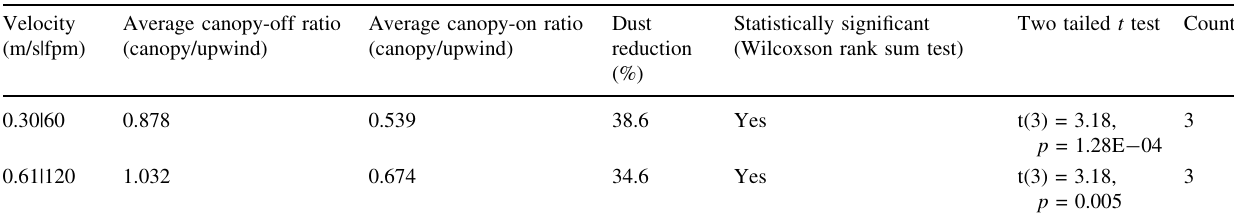
Table 12 Summary of dust control efficiency for the CAC 10-in. height underneath the canopy using Medium Fan #2 Velocity